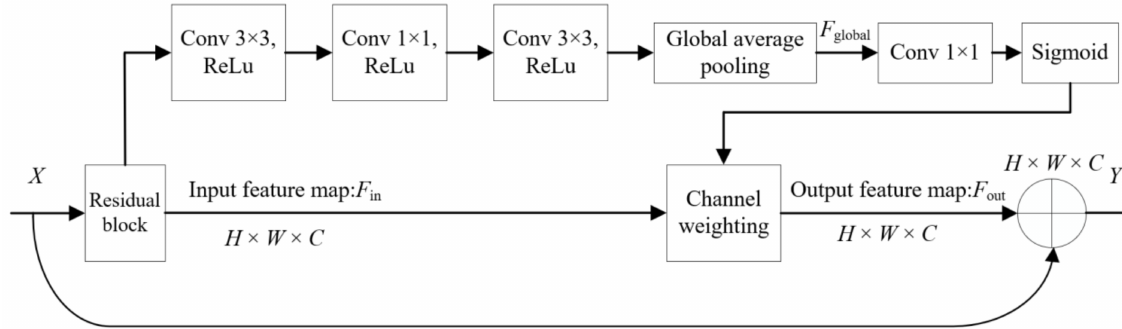
Figure 6. The structure of